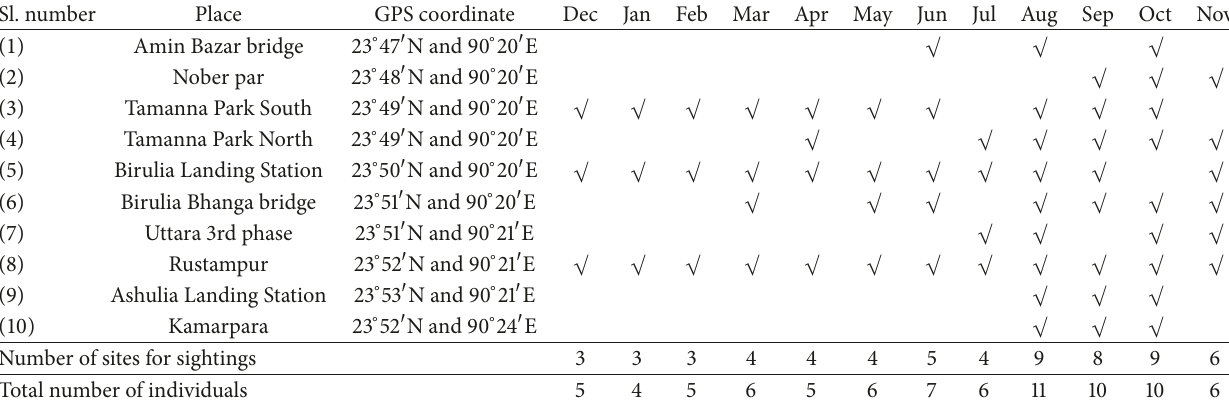
Table 1: River dolphin appears at different geographical position on different time in the Turag River. Sl. number